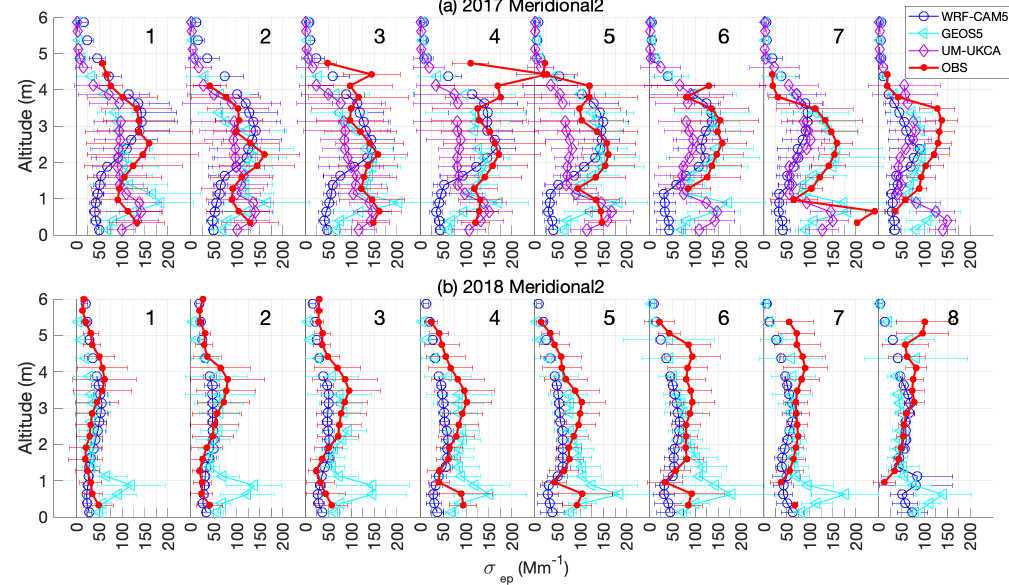
Figure 9. As in Fig. 8 but for the HSRL-2 retrievals of σ ep from the P-3 aircraft along the (a) 2017 and (b) 2018 meridional 2 transect.